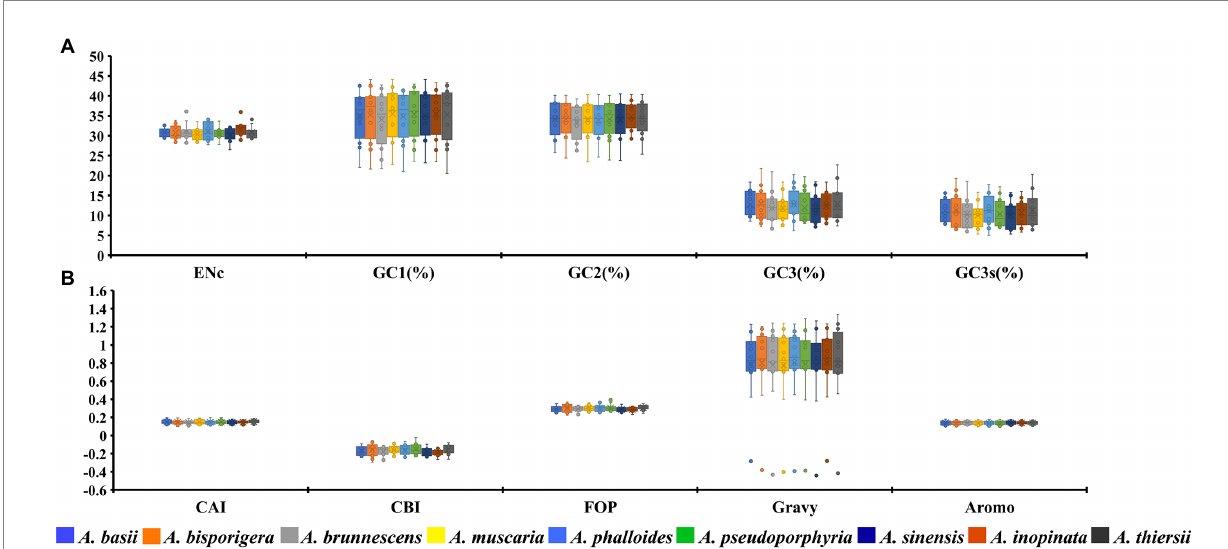
FIGURE 1 Box plot of codon usage indicators of 12 mitochondrial core protein-coding genes in different species of Amanita . A, ENc, GC1, GC2, GC3, and GC3s indicators; B, CAI, CBI, FOP, Gravy, and Aromo